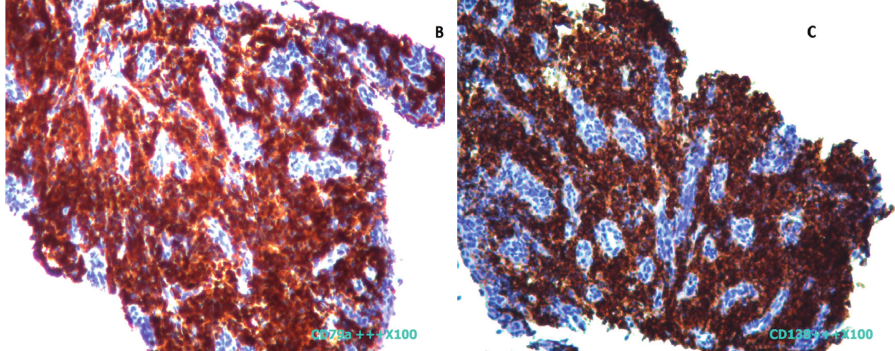
Figure 2: (a) Immunohistochemical examination of biopsy sample showing positivity in majority of tumor cells for CD79a and (b) CD138.